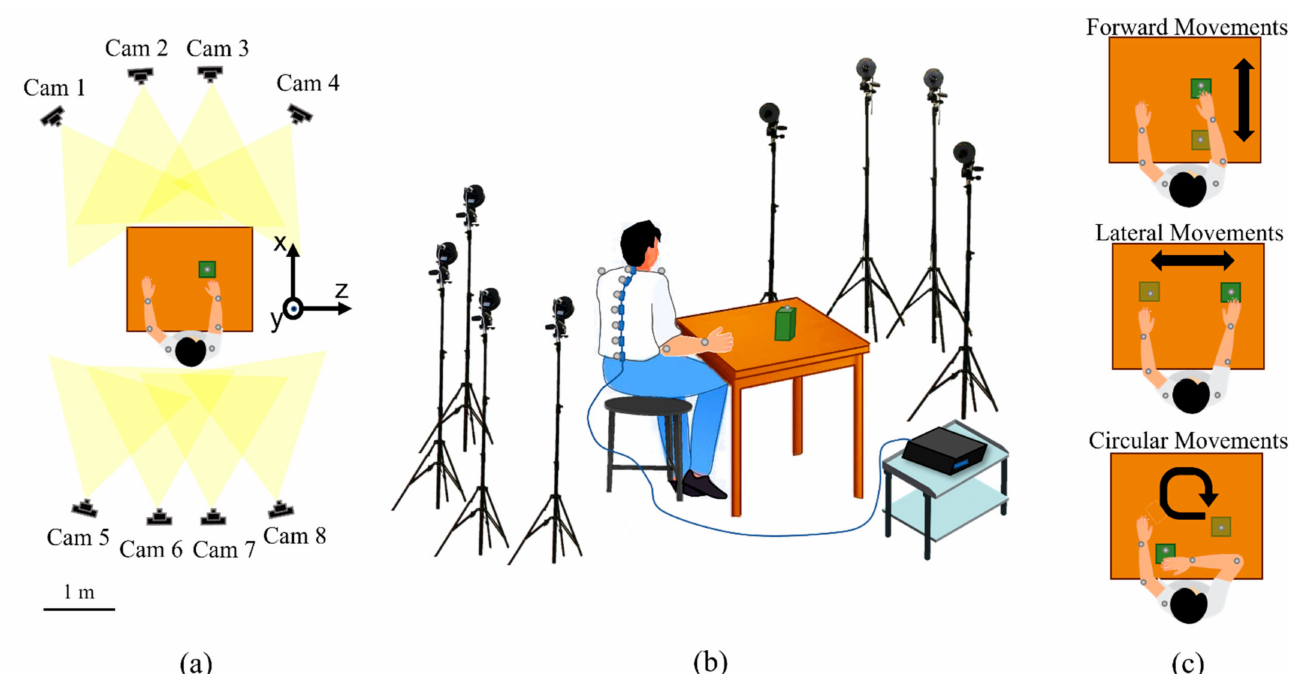
Figure 6. Experimental setup and protocol. ( a ) Upper view showing the positioning of the eight cameras and the reference axes. ( b ) The experimental set-up showing the subject’s positioning, the MoCap system, the wearable system, and the spectrum interrogator. ( c ) Illustration of the three tasks performed during the